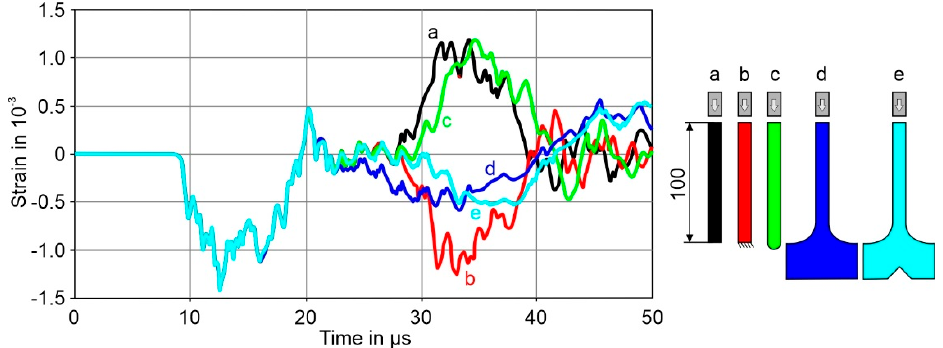
Figure 11. Influence of different measuring body geometries and boundary conditions on the resulting strain signal (mid, 10 mm from the upper end) for an impact test to the steel measurement body.